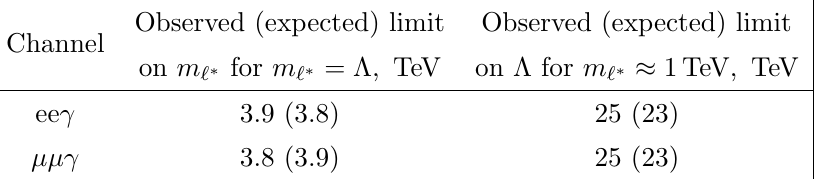
Table 4 . Summary of the observed (expected) lower limits on m ‘ (cid:3) , assuming (cid:3) = m ‘ (cid:3) , and the best observed (expected) lower limits on (cid:3) in the mass range 0.5{1.0 TeV. The lower limit on m depends on (cid:3) since both m and (cid:3) are free parameters in ‘ (cid:3) ‘ (cid:3) the reference model. The observation excludes m < 3 : 9 (3.8) TeV for excited electrons ‘ (cid:3) (muons) in the case where (cid:3) = m . The exclusion on (cid:3) ranges from 15 to 25 TeV in ‘ (cid:3) the mass range m between 0.25 and 1.0 TeV, and decreases with increasing mass up to ‘ (cid:3) approximately 4 TeV for m > 1 : 0 TeV. The best observed limit on (cid:3) is obtained in the ‘ (cid:3) mass range between 0.5 and 1.0 TeV, excluding (cid:3) below 25 TeV for both excited electrons and muons. A summary of representative exclusion limits is given in table